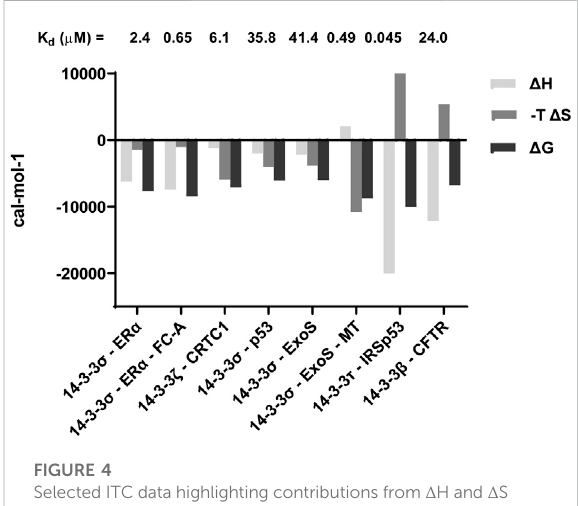
FIGURE 4 Selected ITC data highlighting contributions from Δ H and Δ S to Δ G, and thus the K d . Previously reported data for the following PPIs is included: 14-3-3 — ER α (Falcicchio et al., 2021); 14-3- 3 ζ — CRTC1 (Chen et al., 2021); 14-3-3 σ — p53 (Kuusk et al., 2019);14-3-3 σ — ExoS(Guillory etal.,2021);14-3-3 τ — IRSp53 (Kast and Dominguez, 2019); 14-3-3 β — CFTR (Stevers et al.,